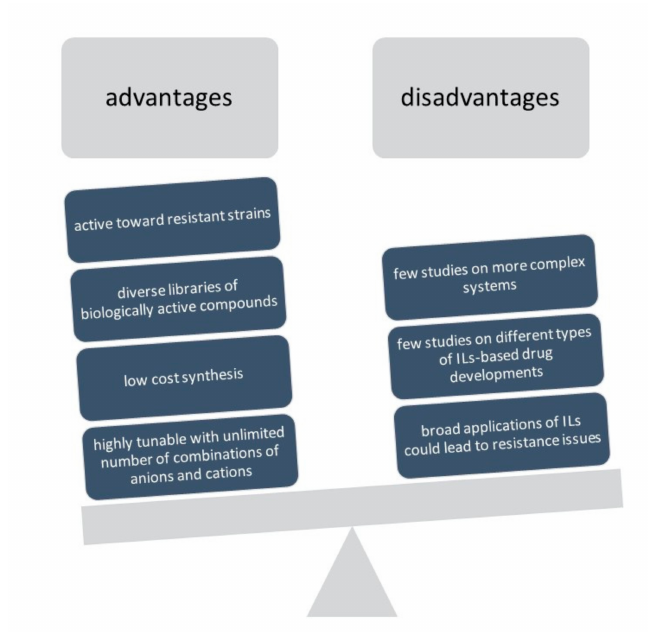
Figure 3. Advantages and disadvantages of the use of ILs as antimicrobial agents, adapted from Ferraz et. al. (2018)